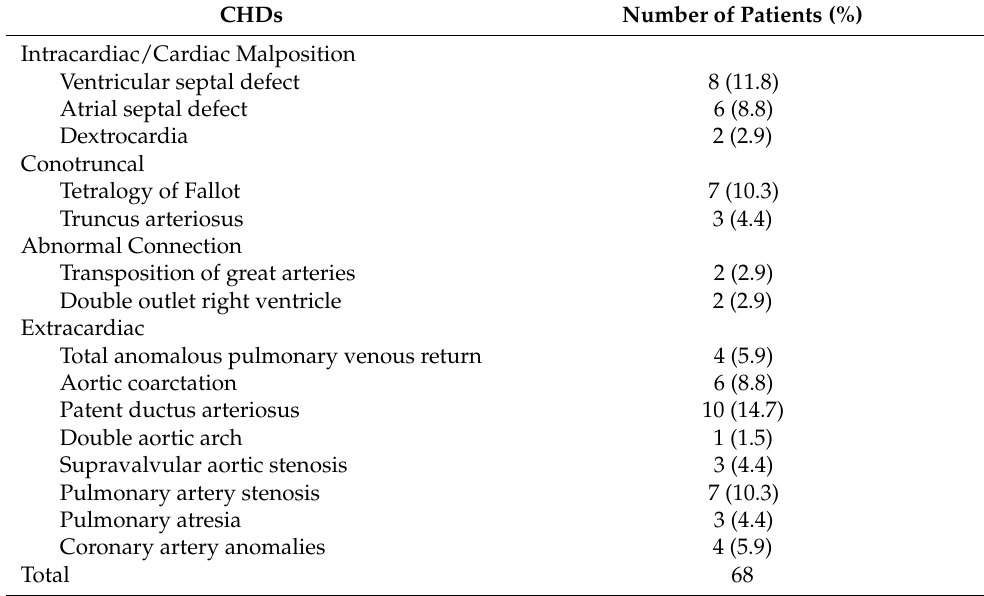
Table 4. CHDs in 42 patients.